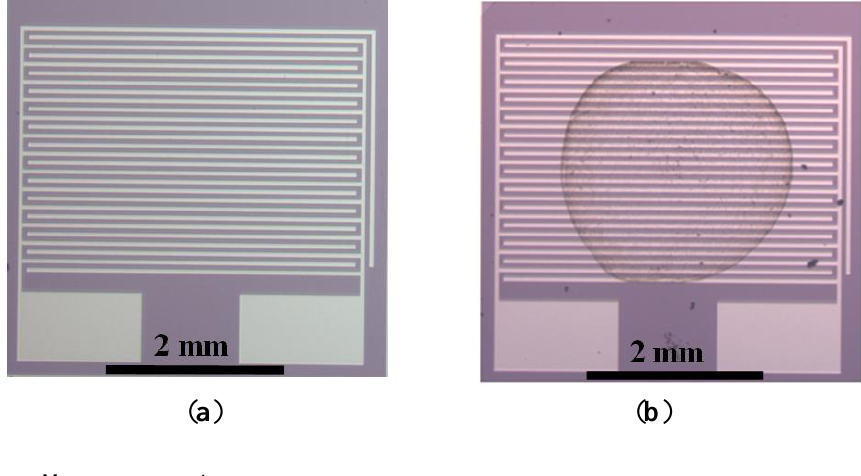
Figure 1. Images of the device: ( a ) two interdigitated platinum electrodes on silicon dioxide; ( b ) device with Pd deposited by drop